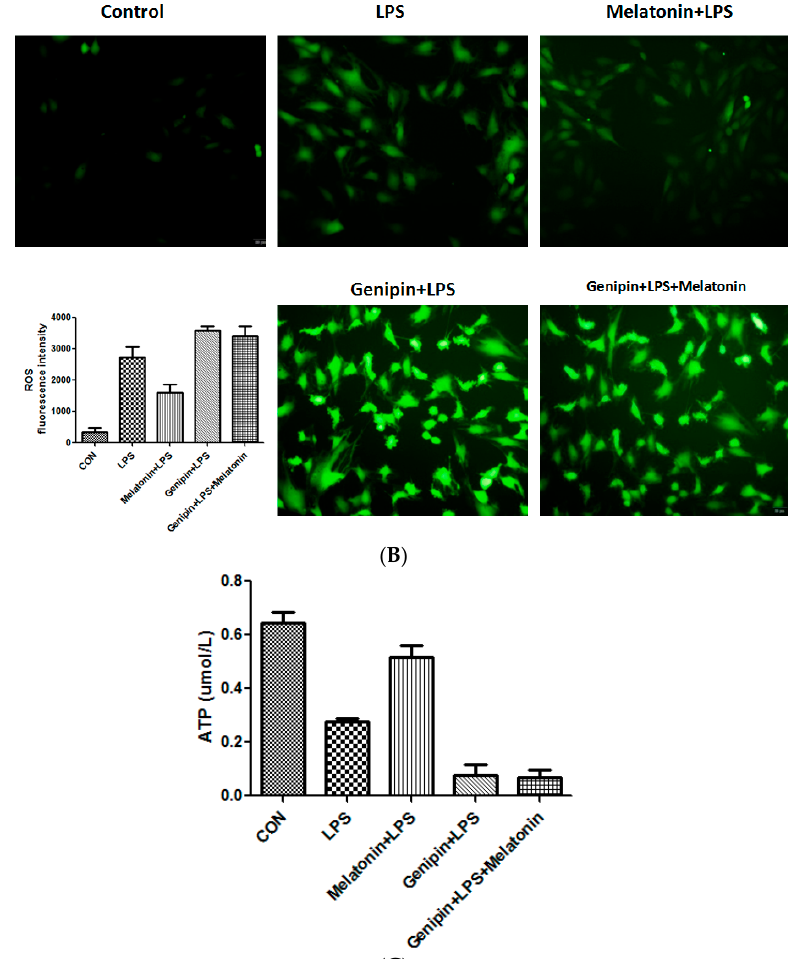
Figure 6. Effect on calcium loading, reactive oxygen species (ROS) and ATP synthesis in the cultured AC16 cells. Panel ( A ): Effect on calcium loading in the cells treated with indicated reagents. Insert: an average of fluorescence intensity. Panel ( B ): Effect on ROS production in the cells treated with indicated reagents. Insert: An average of fluorescence intensity. Panel ( C ): Effect on ATP synthesis in the cells treated with different reagents. Vertical axis: ATP level (µmol/L); horizontal axis: treatment.